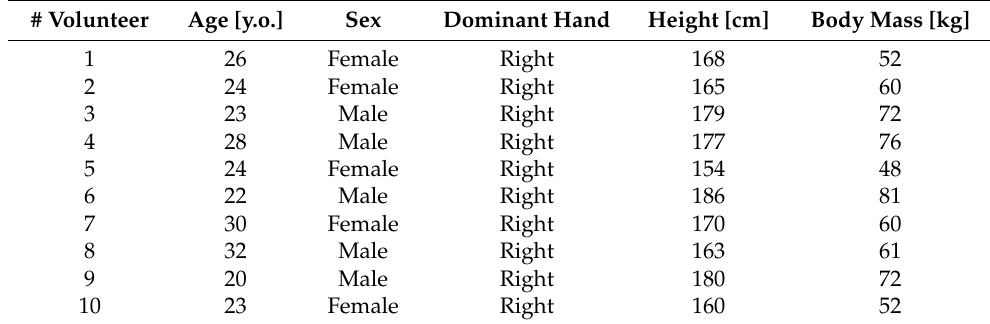
Table 3. Features of the healthy